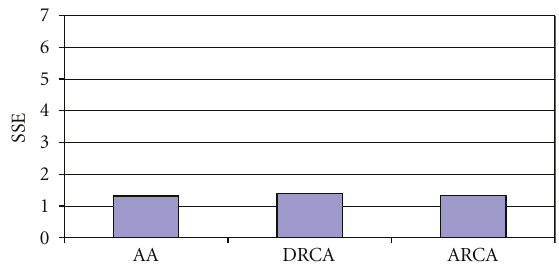
Figure 6: Sum of squared errors in Case 3.